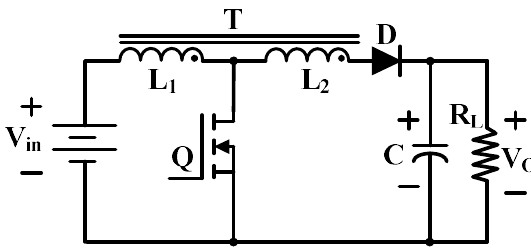
Figure 15. Tapped inductor boost convertor.